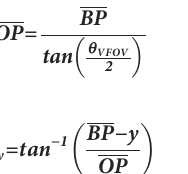
(Figure 4). The distance from the camera to the principal point ( OP ) (equation 5) is used to determine the angle from the camera subtended by pixel y at E ( OE ) and OP (equation 6).